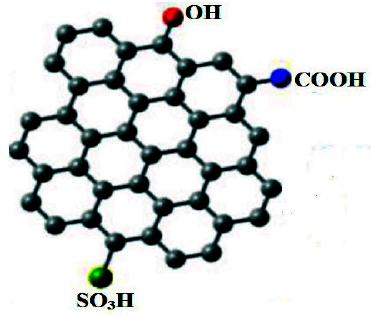
Figure 6. Schematic structure of a sulfonated carbon-based catalyst [127].